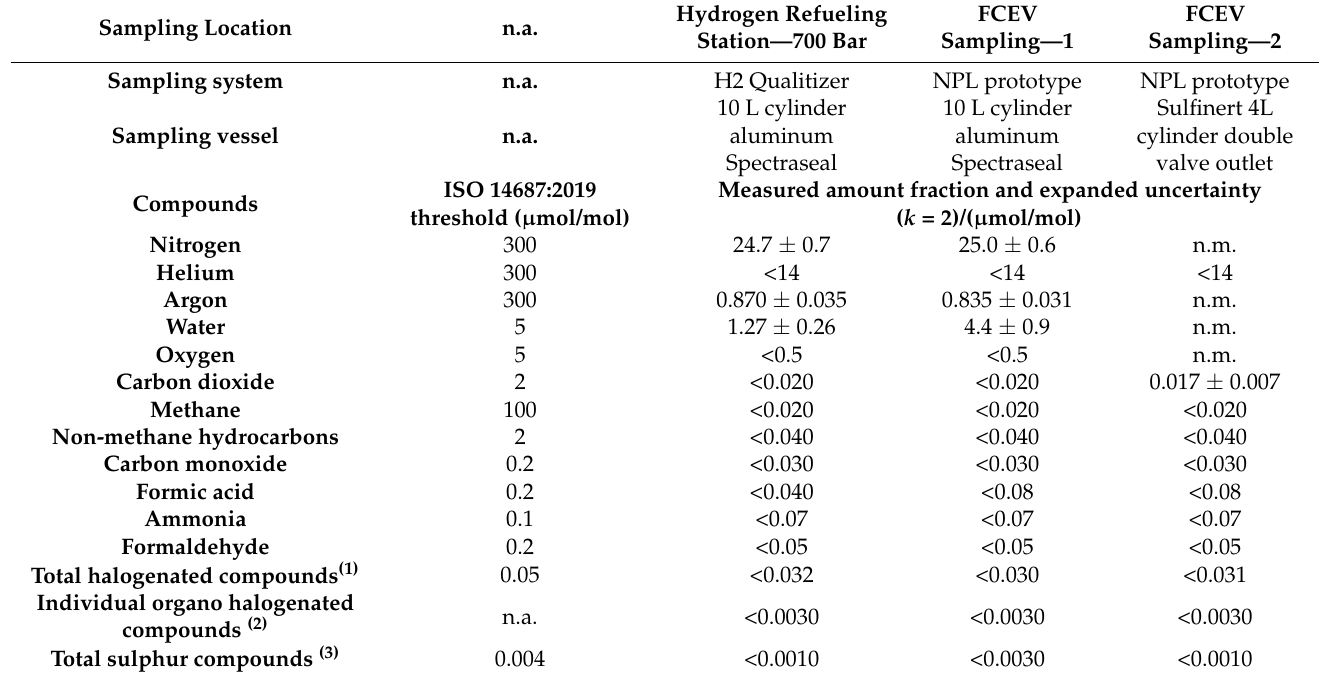
Table 1. Results of analysis for all the contaminants mentioned in ISO 14687 standard from a sample obtained at the HRS and from samples obtained from the FCEV. (1) total halogenated compounds reported as the sum of the amount fraction of organo-halogenated compounds listed in ASTM D7892-15. (2) individual organo-halogenated compounds refer to the highest limit of detection for an individual halogenated compound listed in ASTM D7892-15. (3) reported as an amount fraction of total sulphur in the sample. n.a. means not applicable; n.m. means not measured as the analysis was not realised due to insufficient